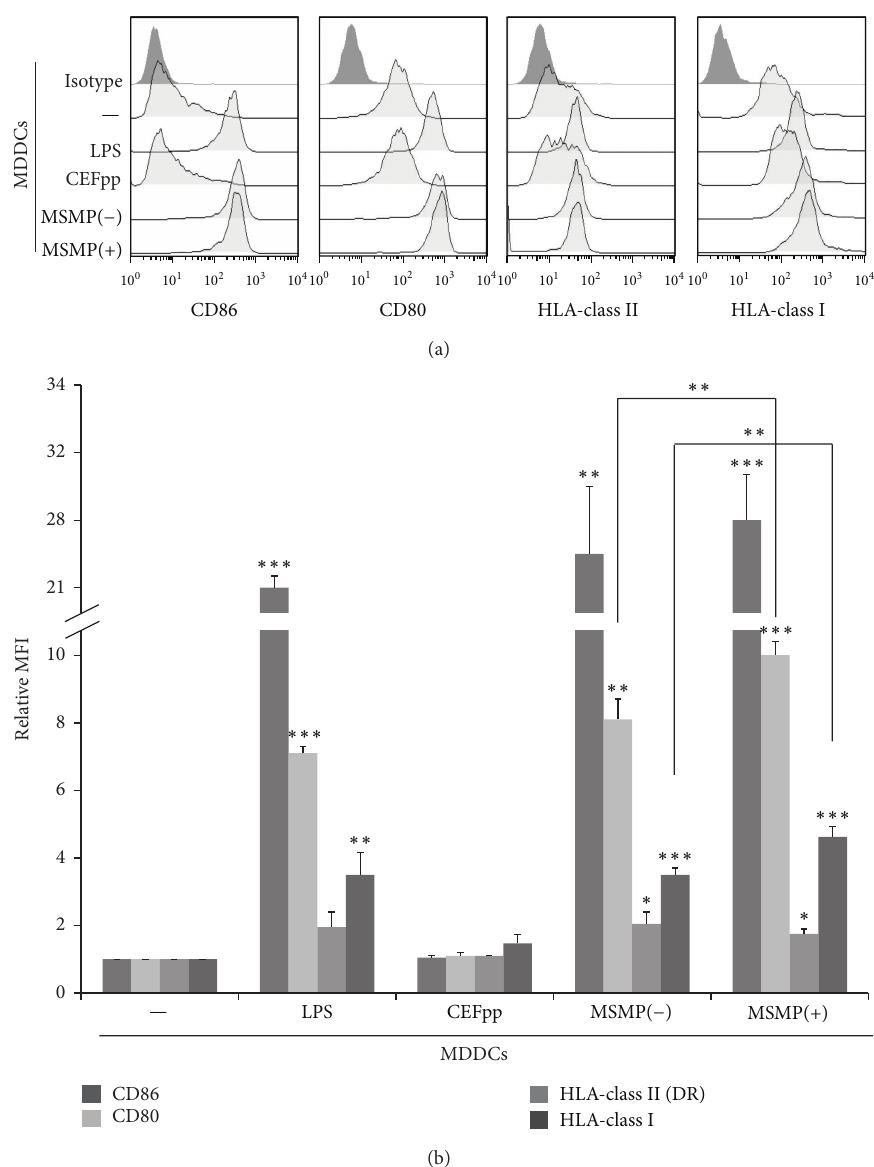
Figure 4: Dendritic cells maturation by MSMPs. (a) Representative histograms of dendritic cells maturation determined by quantifying the presenceofthefollowingactivationmarkers:HLA-classI,CD80,CD86,andHLA-classII(DR)ontheircellsurfacebyflowcytometry.Isotype: irrelevant antibody; ( − ): MDDCs alone; CEFpp: MDDCs exposed to antigenic peptide (CEFpp) alone; MSMPs − : MDDCs with microparticles withoutCEFpp;MSMPs+:MDDCswithmicroparticlesloadedwithCEFpp;LPS:lipopolysaccharide.(b)Relativemeanfluorescenceintensity. Mean ± SD ( 𝑛 = 4 ). ∗ 𝑃 < 0.05 ; ∗∗ 𝑃 < 0.03 ; ∗∗∗ 𝑃 < 0.01